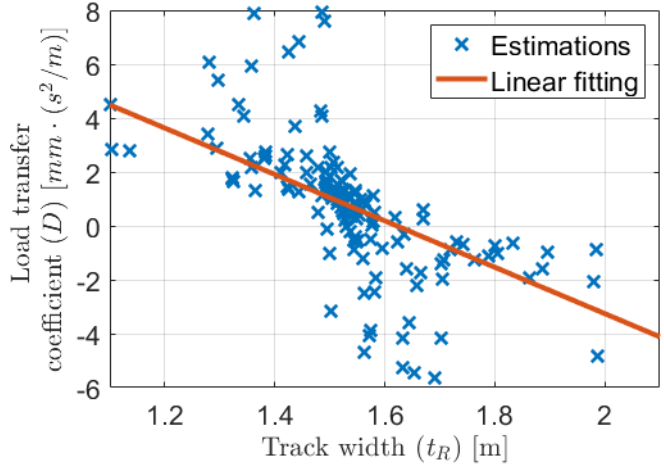
Figure 23. Estimated t R − D